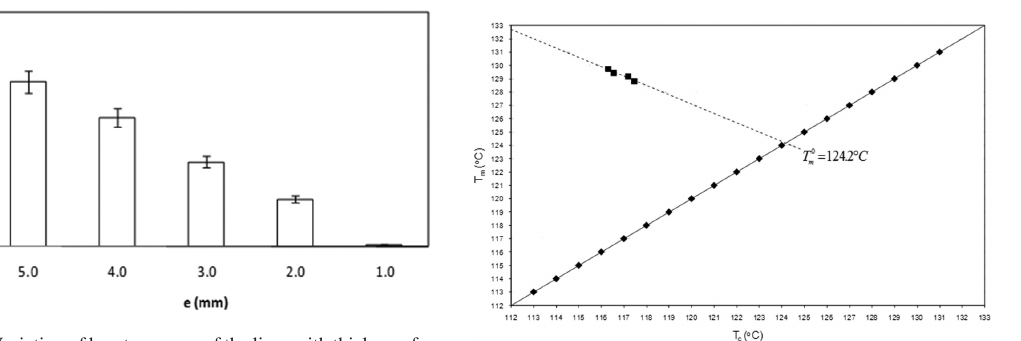
Figure 6. Variation of burst pressure of the liner with thickness for the LH05 polymeric blend.